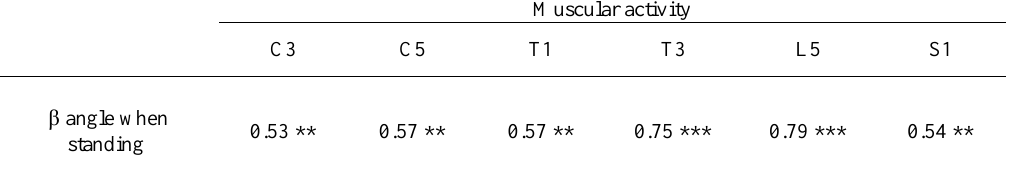
Correlations between sEMG Measures Along the Spine) and the Horses’ Neck Shape Angle Muscular activity C3 C5 T1 T3 L5 S1 β angle when 0.53 ** 0.57 ** 0.57 ** 0.75 *** 0.79 *** 0.54 ** standing Note. The bigger the β angle, the higher the muscular activity: a hollow neck was associated with a higher prevalence of back disorders all along the spine. From Lesimple et al. (2012). The table indicates the Spearman’s correlation tests’ results ( r values are indicated in the